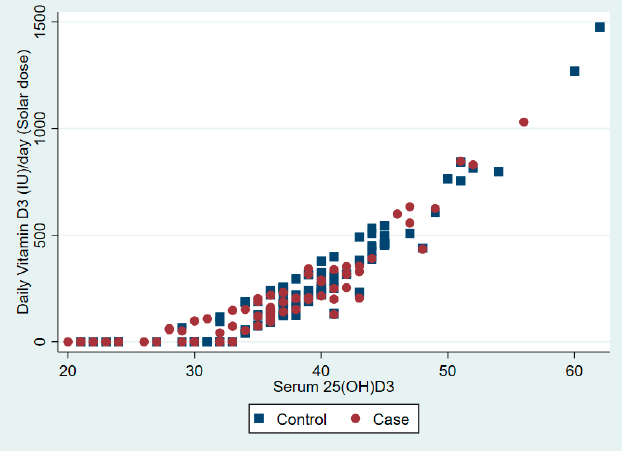
Figure 1. The association between serum vitamin D 25(OH)D and daily vitamin D from dietary intake.